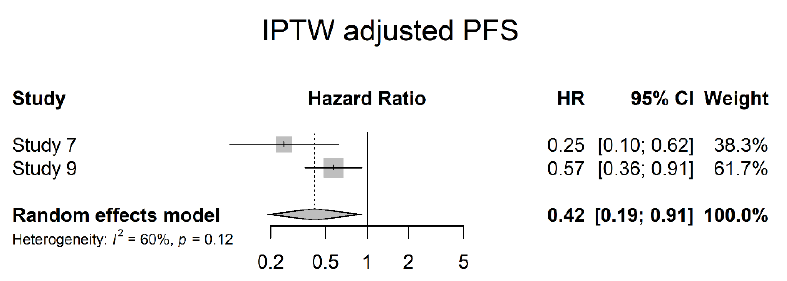
Figure 15. IPTW adjusted progression-free survival.